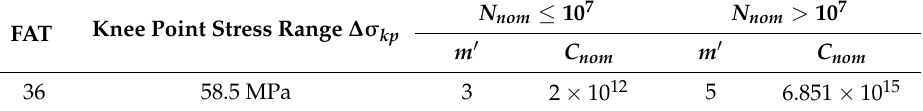
Figure 16. FAT36 curve.